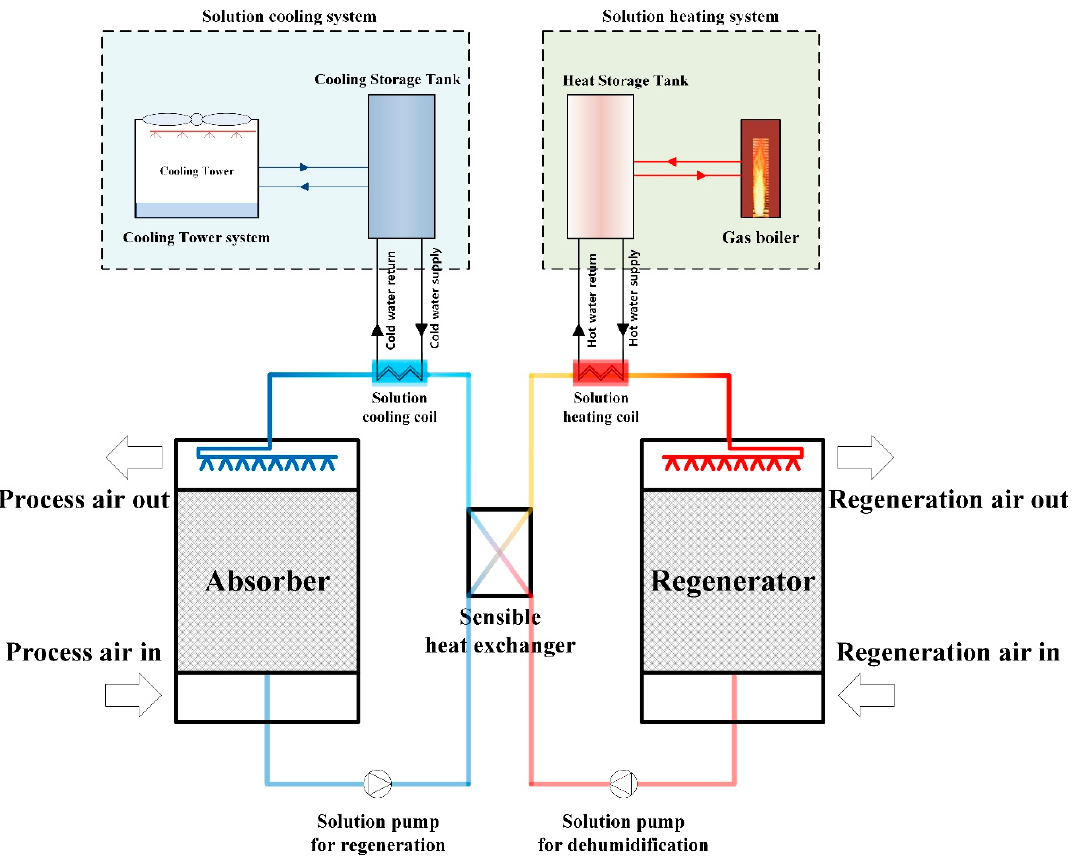
Figure 3. Schematic diagram of the conventional liquid desiccant (LD) system.